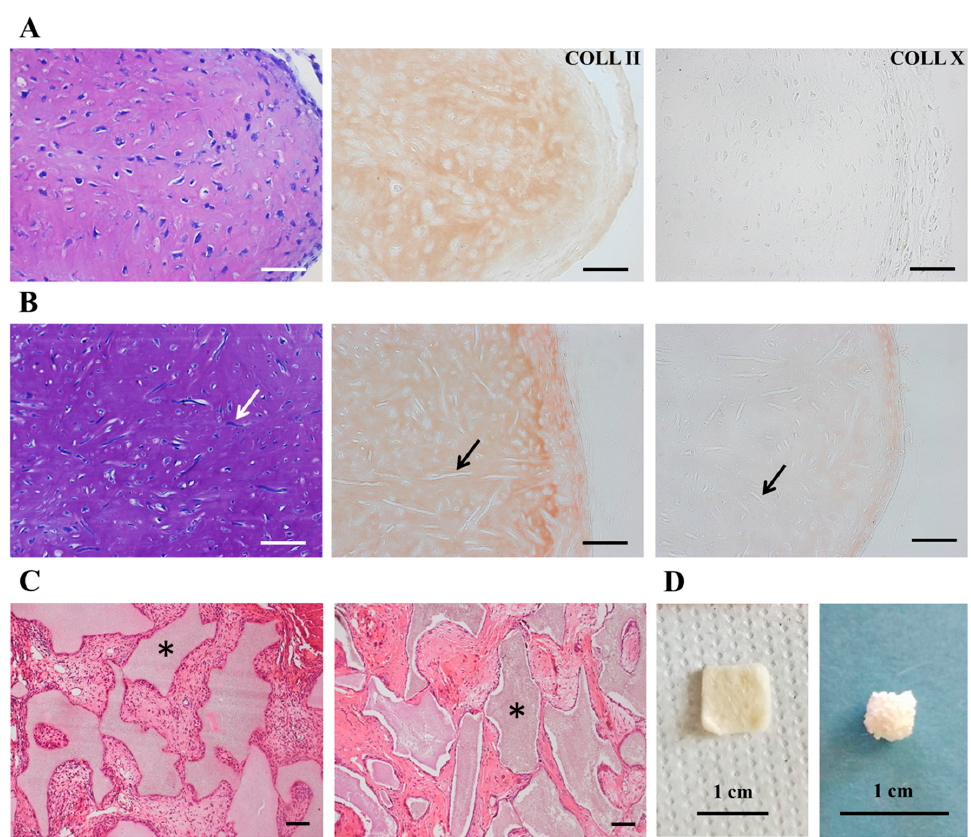
Figure 6. In vivo ectopic chondrogenesis and osteogenesis assay of CPCs. ( A , B ) Histological analysis of ectopic cartilage formed in vivo after subcutaneous implantation of CPC-pellets ( A ) and CPCs-seeded biomaterials ( B ) in nude mice; from left to right: toluidine blue staining, type II and type X collagen stainings. Arrows point out the remnants of polyglycolic-acid (PGA)-sca ff old fibers. ( C ) Histological analysis by hematoxylin / eosin staining of ectopic tissue formed in vivo after subcutaneous implantation of ACs-FBS (left) or CPCs (right)-seeded osteoinductive sca ff olds in nude mice. Asterisks point out the biomaterial. ( D ) Representative view of selected sca ff olds, polyglycolic-acid–hyaluronan (PGA-HA) mat (left) and hydroxyapatite / β -tricalcium phosphate (HA / β -TCP) assembled granules (right). Scale bars correspond to 50 µ m (upper panel), 100 µ m (middle and bottom panels) and 1